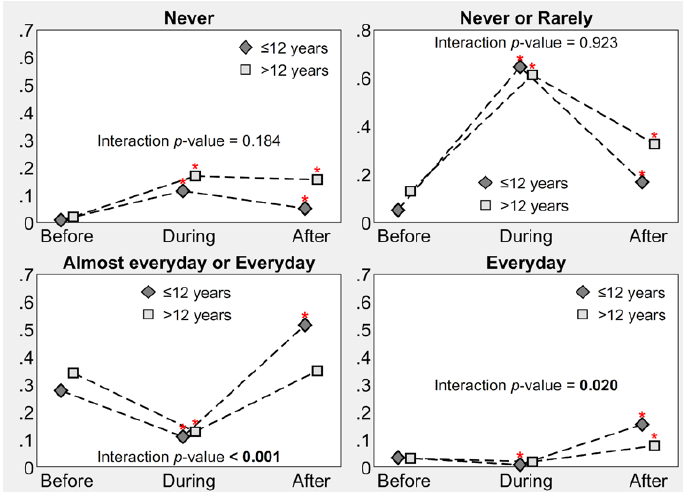
Figure 3. Frequency of child PA before, during, and after Italy’s national lockdown, by gender. Point estimates of proportions derive from multilevel mixed-effects generalized ordered probit regres- sion; * indicates a significant increase or decrease relative to before the national lockdown ( p -value ≤ 0.05); the interaction p -value indicates whether males and females have significantly different in- crements or decrements in physical activity before and after the national lockdown. Note : Six chil- dren with missing sex were excluded ( n = 1128); all estimates were adjusted for age group ( ≤ />12 years).